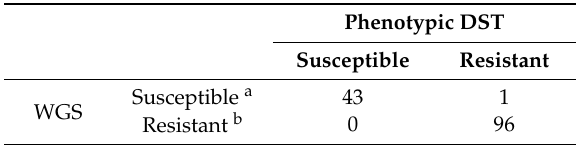
Table 2. Agreement between phenotypic DST results and identified point mutations in the 23S rRNA gene at nucleotide positions, A2146 and A2147, conferring resistance to macrolides ( N = 140). Phenotypic DST Susceptible Resistant Susceptible a 43 1 WGS Resistant b 0 96 a no mutation present at nucleotide positions, A2146 and A2147, in the 23S rRNA gene. b A mutation present at nucleotide positions, A2146 and A2147, in the 23S rRNA gene. DST: drug susceptibility testing.